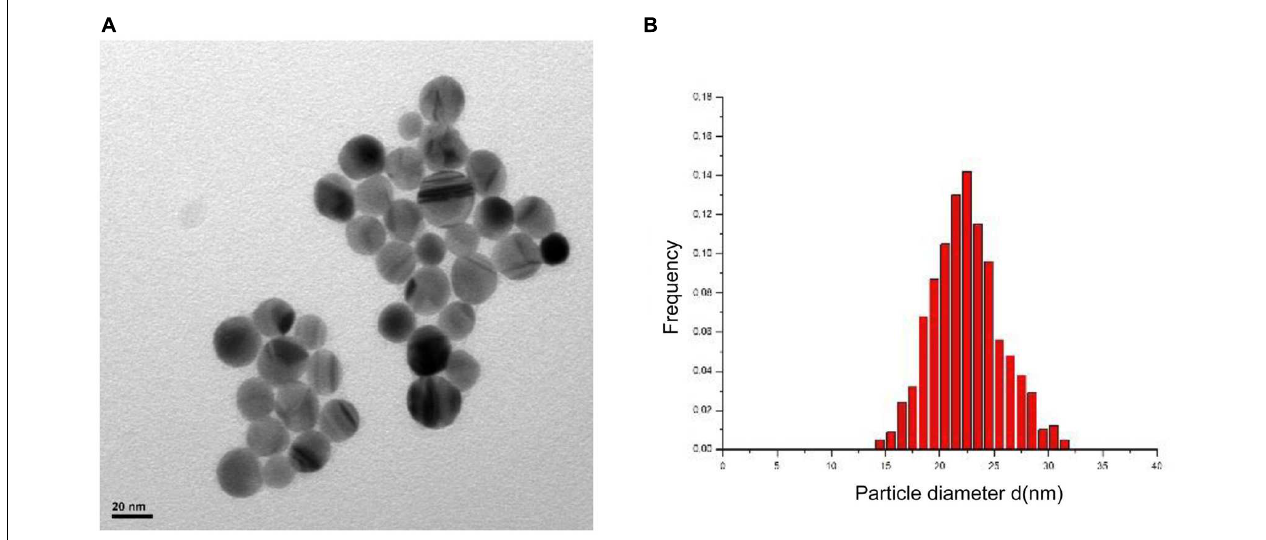
FIGURE 1 | Results of silver nanoparticles (AgNPs) characterization with TEM. Morphology (A) and dimensional distribution (B) .